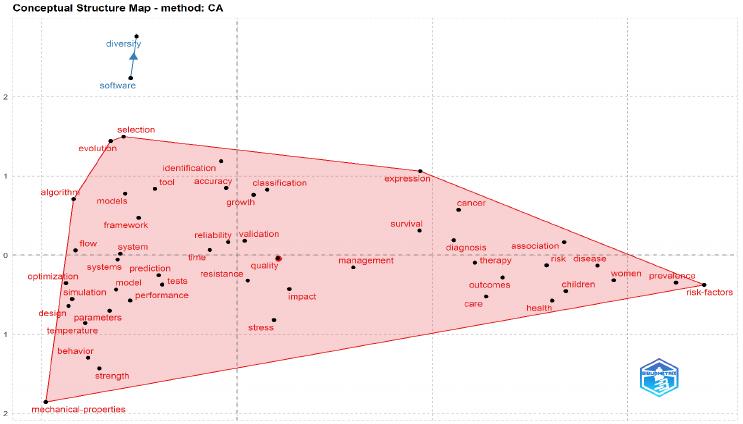
Figure 19. Conceptual Structure Map representing clusters of research themes on the basis of corre- spondence analysis for the years 2019–2021.